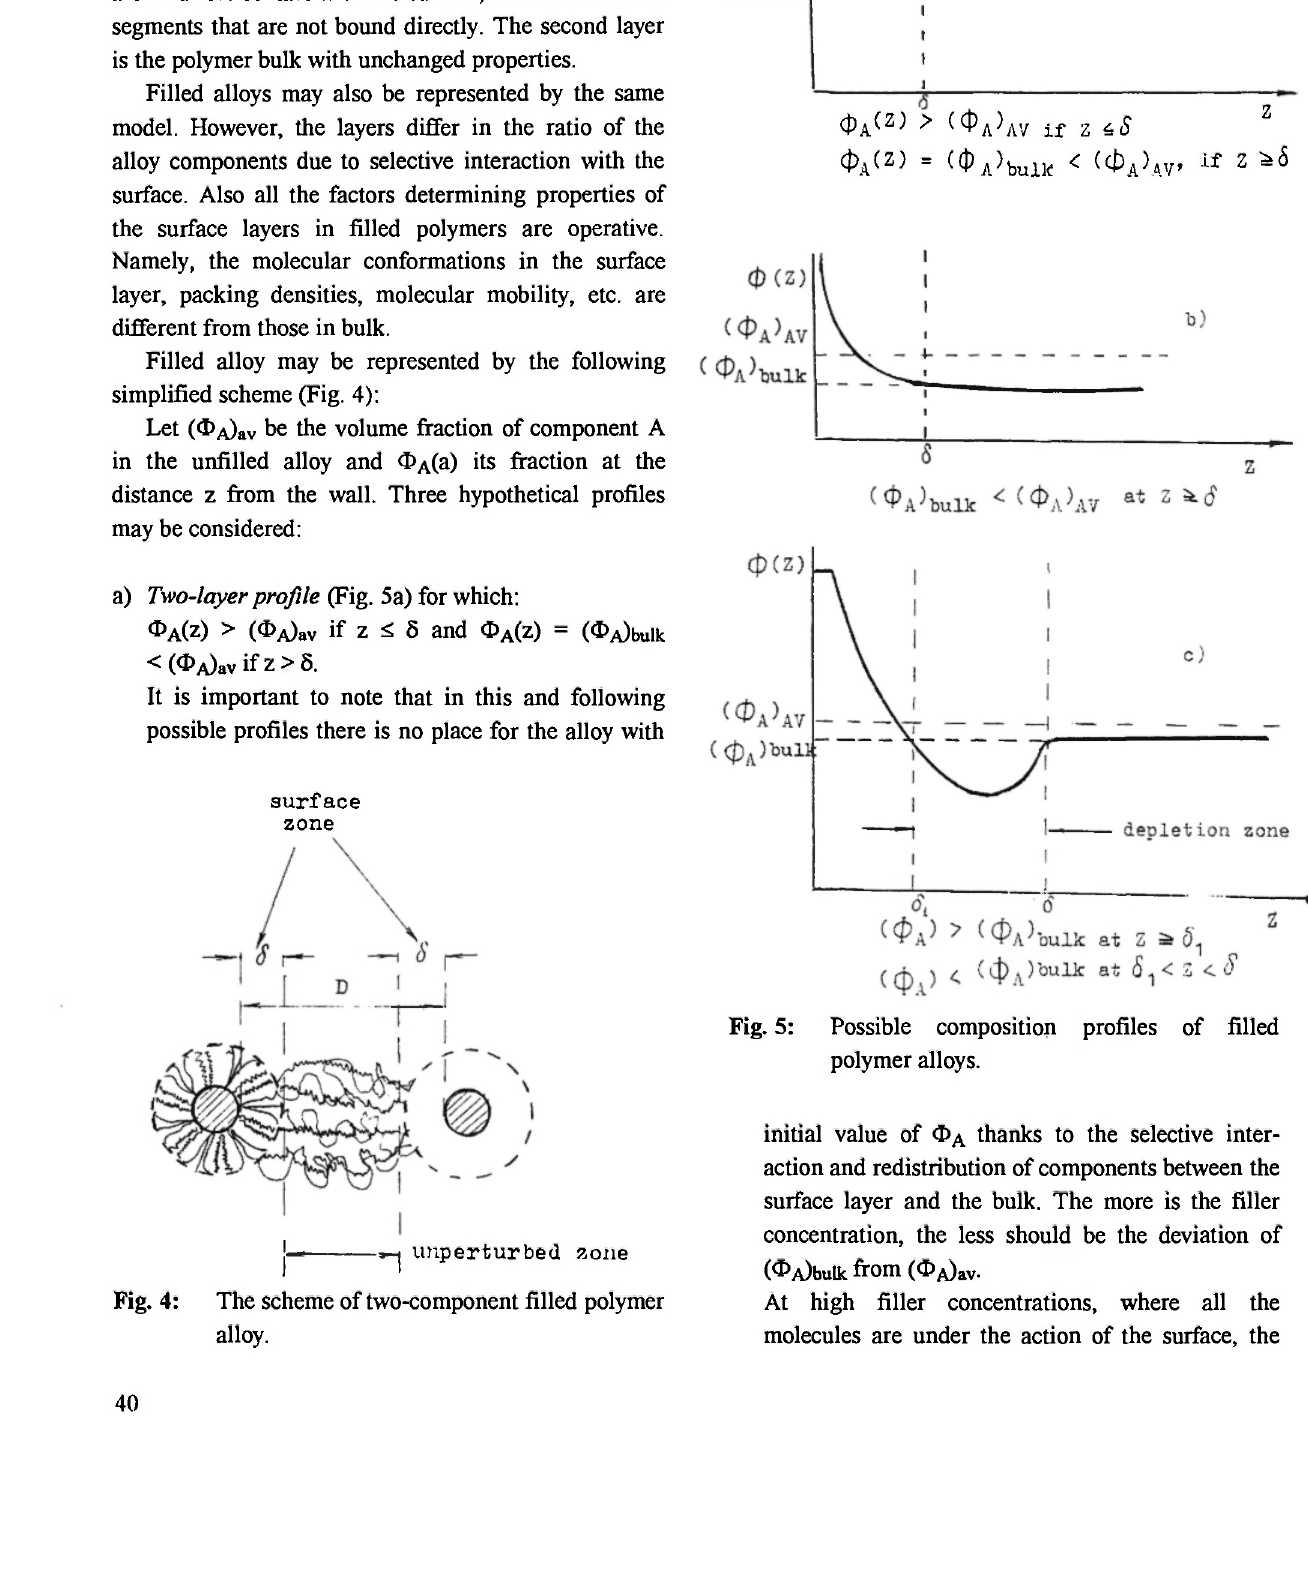
Fig. 5: Possible composition profiles of filled polymer